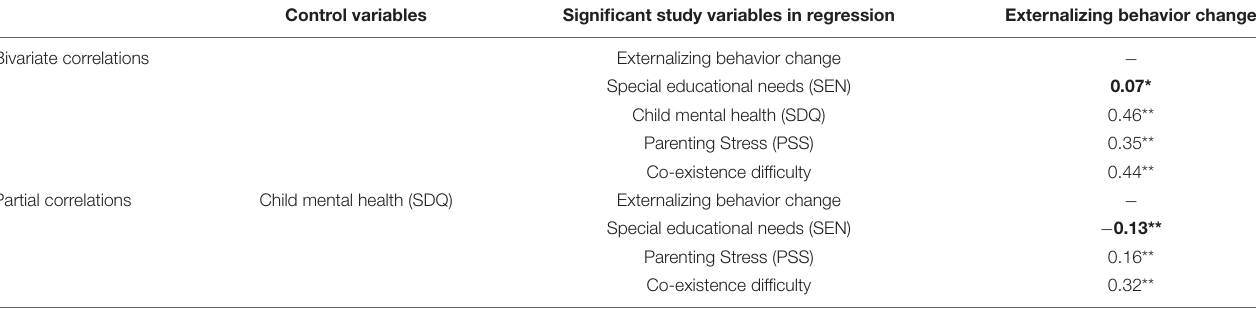
TABLE 5 | Bivariate and partial